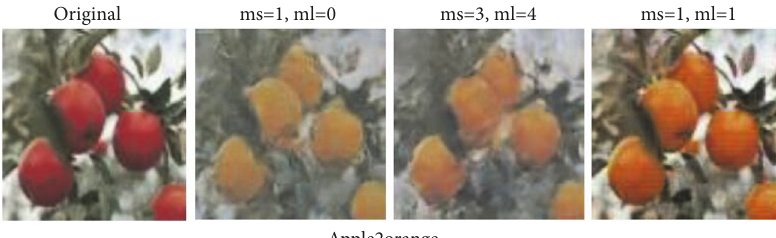
Figure 3: The results of values of different multiscale and multilevel from apple to orange. We show the original image, generated images with different multiscale and multilevel.